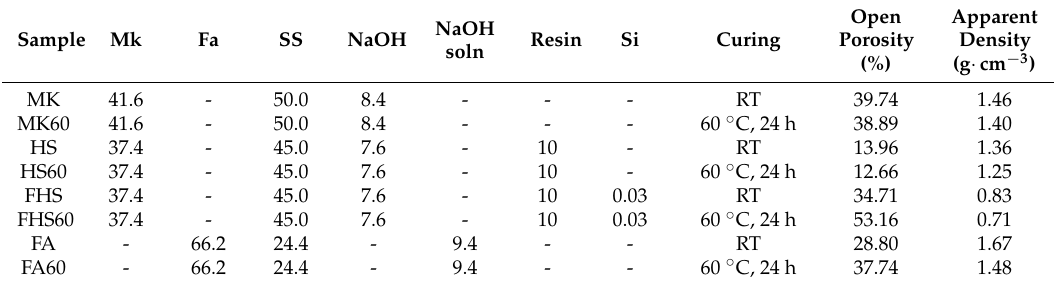
Table 2. Composition (wt %), curing conditions, apparent density, and open porosity of the samples used in this study. Photocatalyst (3% w / w ) was added to all formulations immediately after preparation.